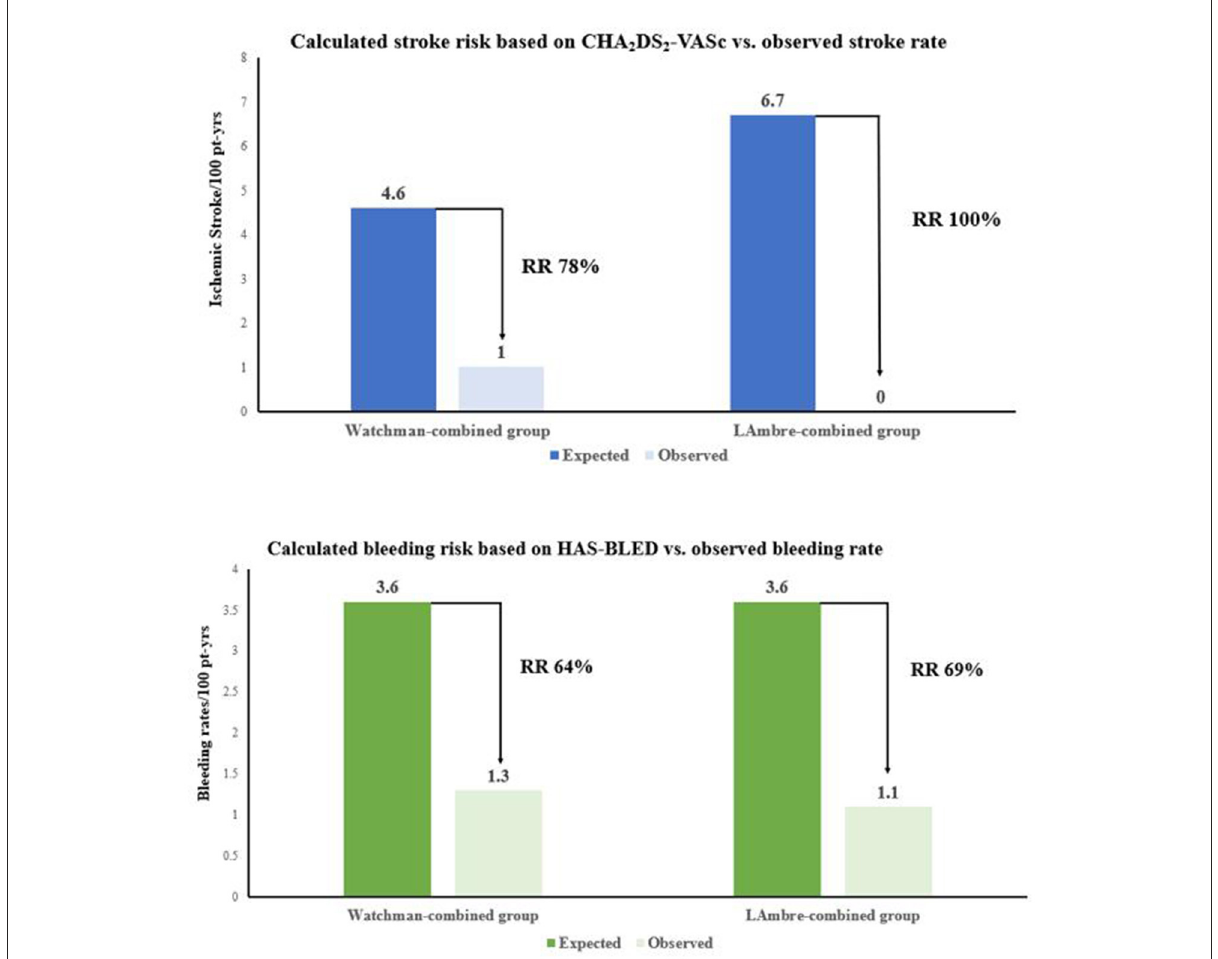
FIGURE1 Effectiveness of combined procedure with Watchman and LAmbre devices in reducing stroke and bleeding